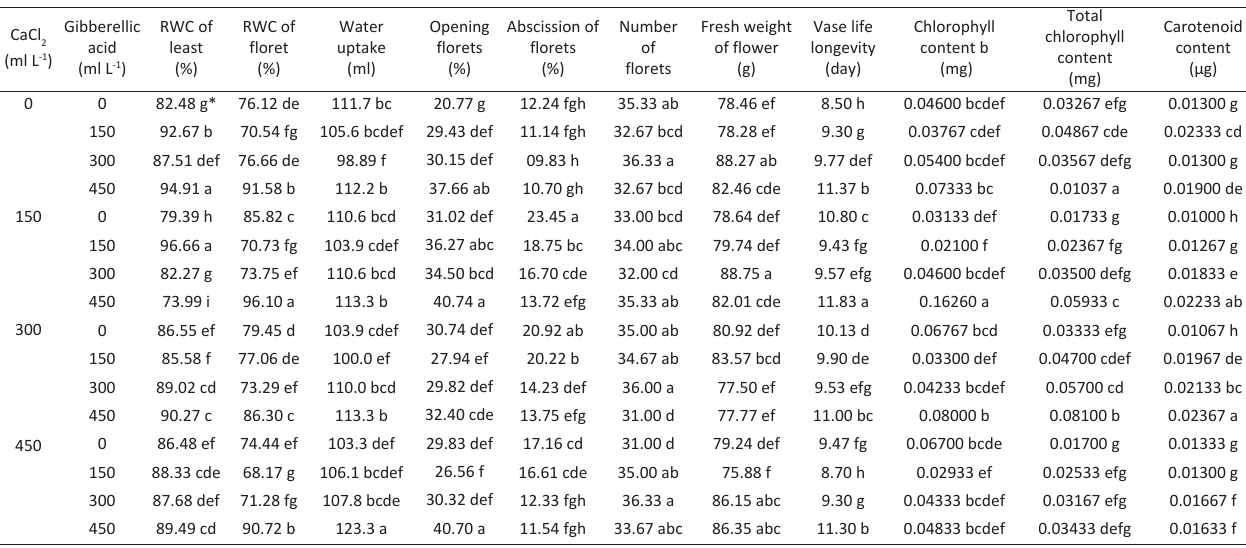
Table 1 - Means of interaction of CaC and gibberellic acid on relative water content (RWC) of leaves and florets (%), water uptake (mL), 2 opening and abscission of florets, number of florets, fresh weight of flower (g), vase life (day), chlorophyll content a, b and total chlorophyll content (mg), and carotenoid content (µg) of cut tuberose ( Polianthes tuberosa L.) after first flower opening of inflorescence Gibberellic CaCl 2 (ml L -1 )